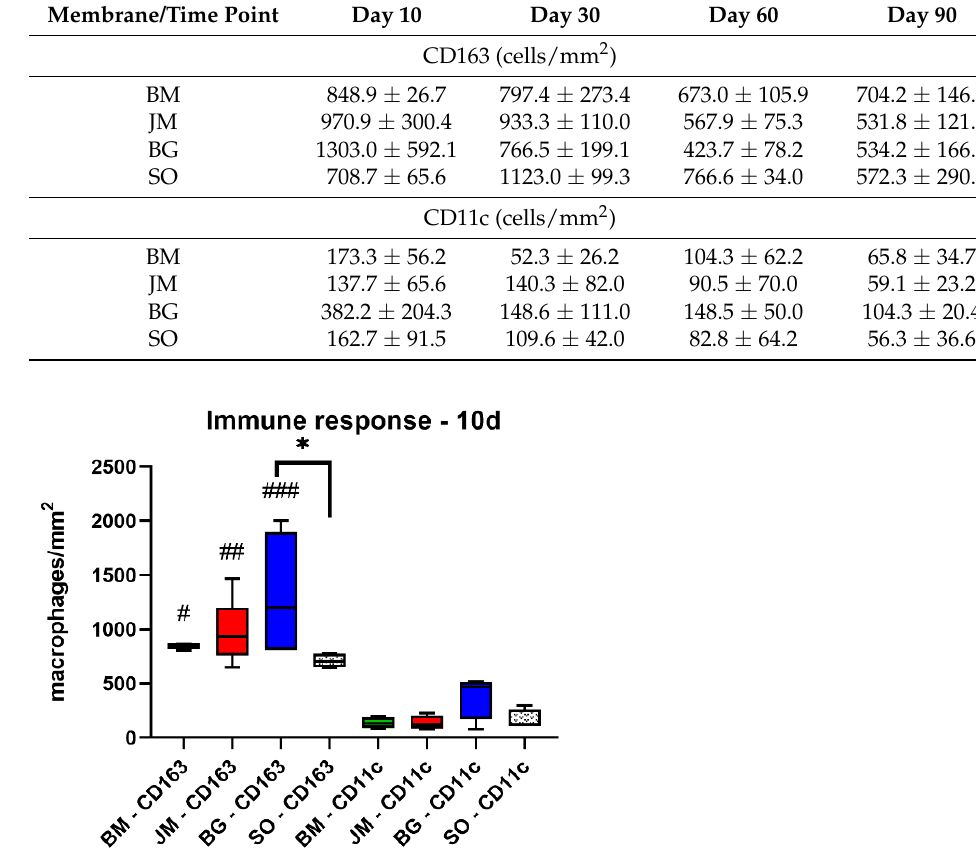
Figure 6. Results of the histomorphometrical measurements of the macrophage distribution at day 10 post implantationem (* = intraindividual differences, # = interindividual differences; ###: p < 0.001 and ##: p < 0.01, */#: p < 0.05).